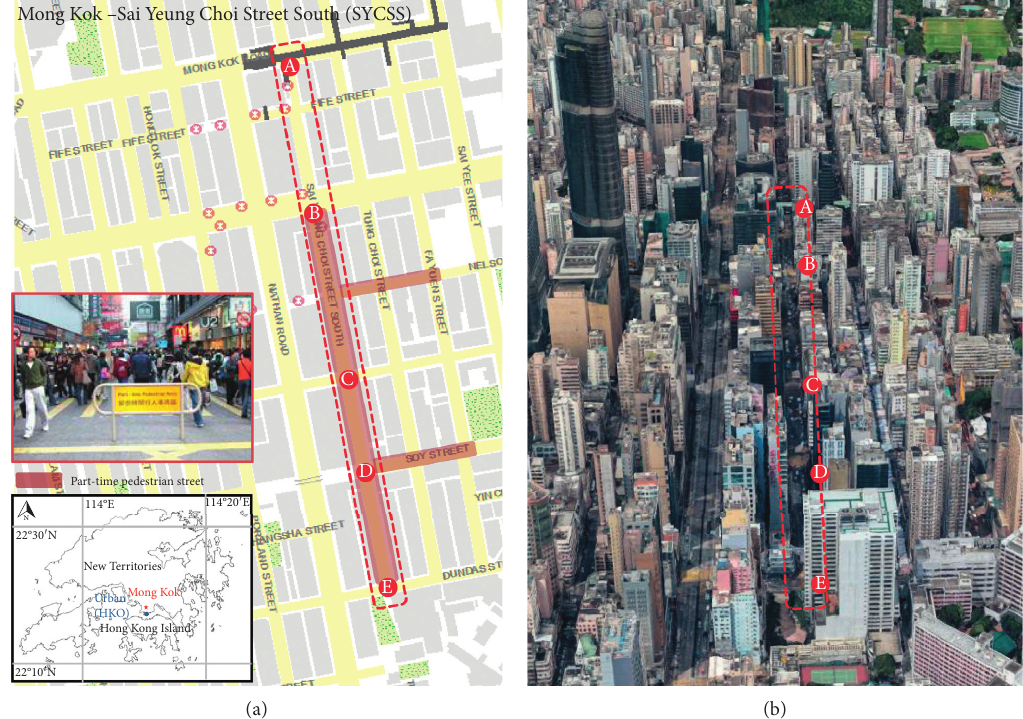
Figure 1: The map (a) and google ™ earth 3D view (b) of Mong Kok with an illustration of the five study locations (A–E) along SYCSS. The photograph shows a section of the part-time pedestrian